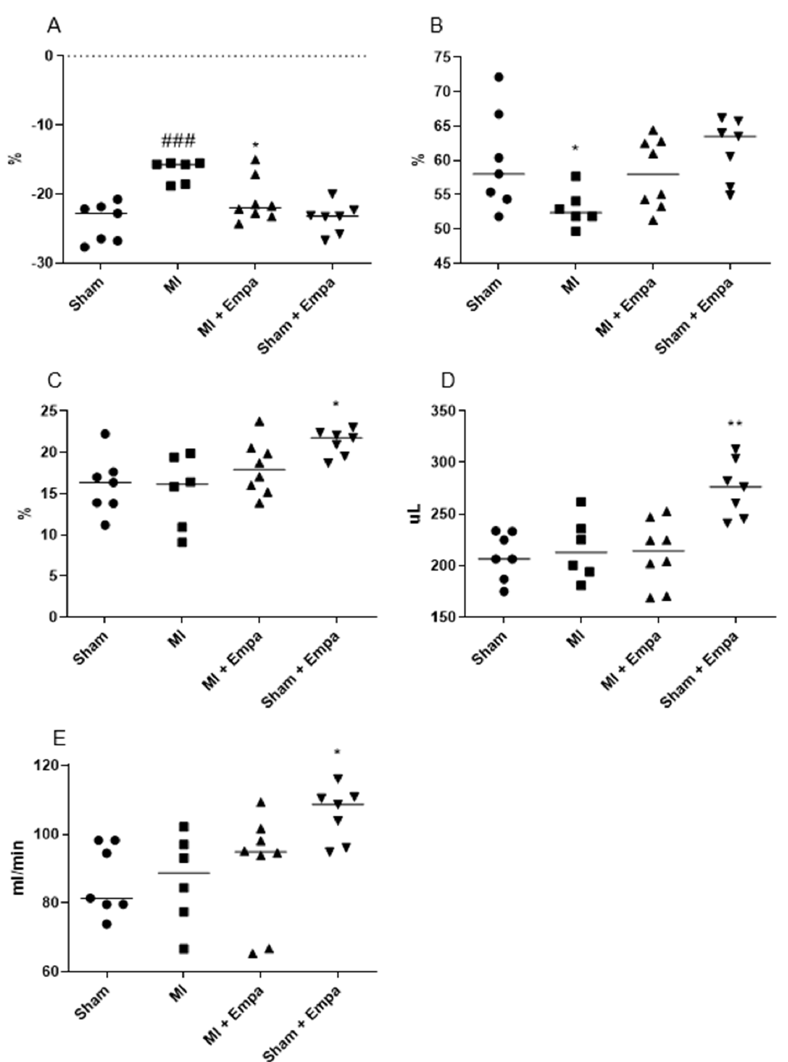
Figure 2. Hemodynamic parameters measured by Transthoracic Doppler Echocardiography 7 days after myocardial infarction (MI). ( A ) Global longitudinal strain (GLS); * P < 0.05 vs. MI, ### P < 0.001 vs. sham; 2-way Anova. ( B ) Ejection fraction (EF); * P < 0.05 vs. MI; unpaired t-test. ( C ) Fractional shortening (FS); y -axis: sham operation, MI vehicle, MI treated with Empa, sham operation treated with Empa; * P < 0.05 vs. sham; 2-way Anova. ( D ) Stroke volume (SV); ** P < 0.01 vs. sham, 2-way Anova. ( E ) Cardiac output; * P < 0.05 vs sham; 2-way Anova. ( n = 7–8), mean ± SEM.